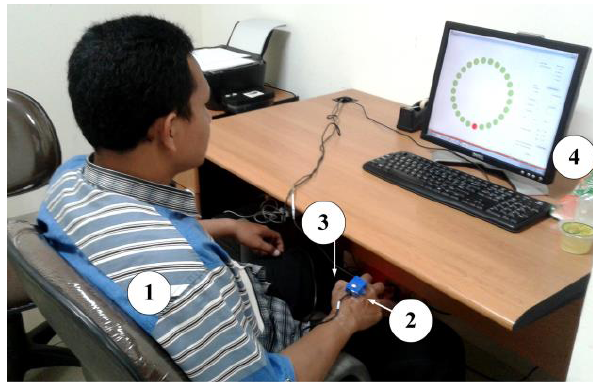
Figure 3. Illustration of experimental conditions: (1) Subject (0.9m from display); (2) Inertial sensor (mounted on the back of the dominant hand); (3) Click part (grasped with the dominant hand); (4) Display (computer monitor).